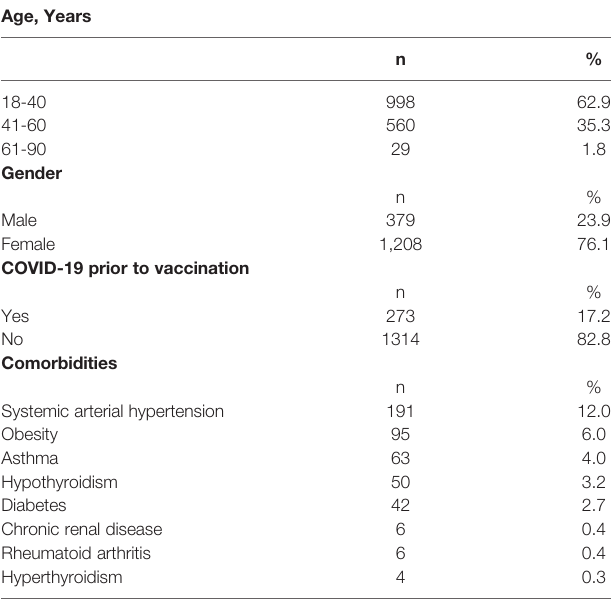
TABLE 1 | Demographic data of participants in the